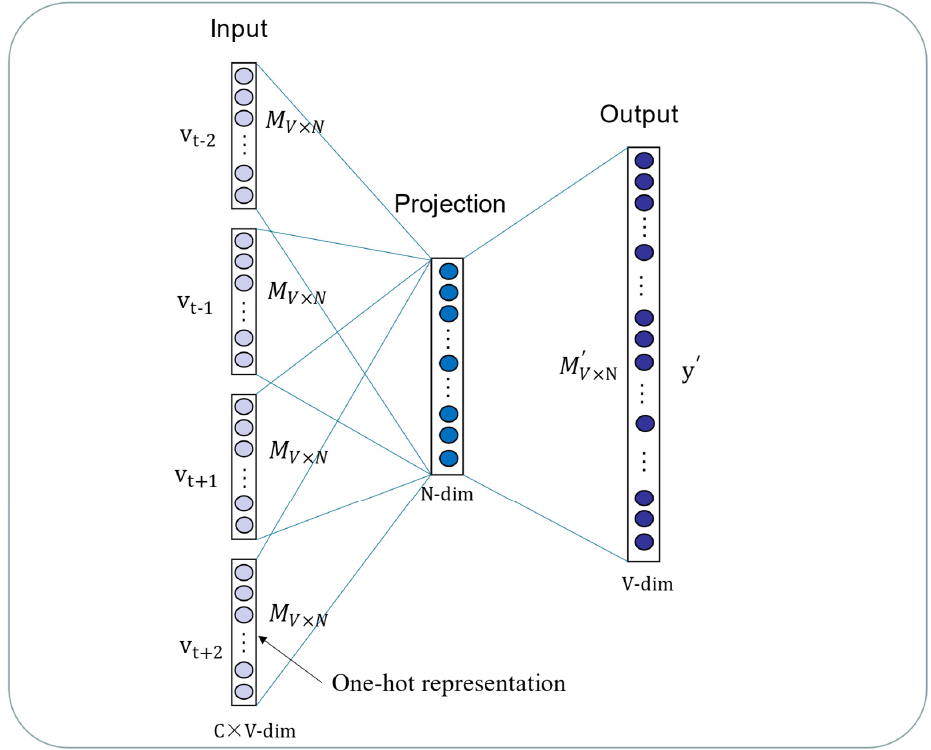
Figure 2. The CBOW model is constructed by the input layer, projection layer and output layer. 2.3. Representing the Association between Drugs and miRNA with Graph Embedding Network-based features are well proven to perform well in the link prediction tasks of heterogeneous graphs [58,59]. The topological feature represents the global structure of the bipartite graph. In contrast to previous studies, which extracted topology information from the network degree and clustering coefficient, the network embedding methods learn low-dimensional representations of nodes in the network [60]. To gain the highly non-linear structure from the bipartite graph, the graph embedding model SDNE is ap- plied to formulate topological features [61]. The deep neural network in SDNE is more effective than shallow models to capture non-linear structures in the network. The SDNE has good performance in sparse networks since it combines first-order and second-order